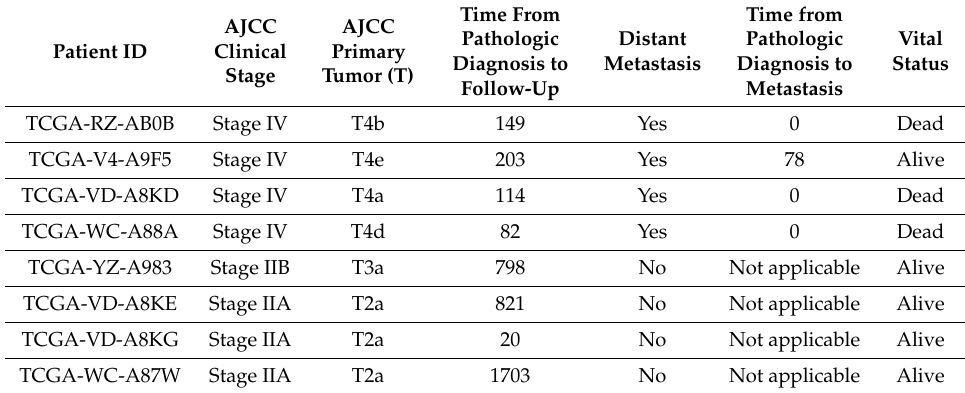
Table 1. Clinical data of The Cancer Genome Atlas (TCGA) patients selected for di ff erential miRNA expression analysis. AJCC: American joint committee on cancer.